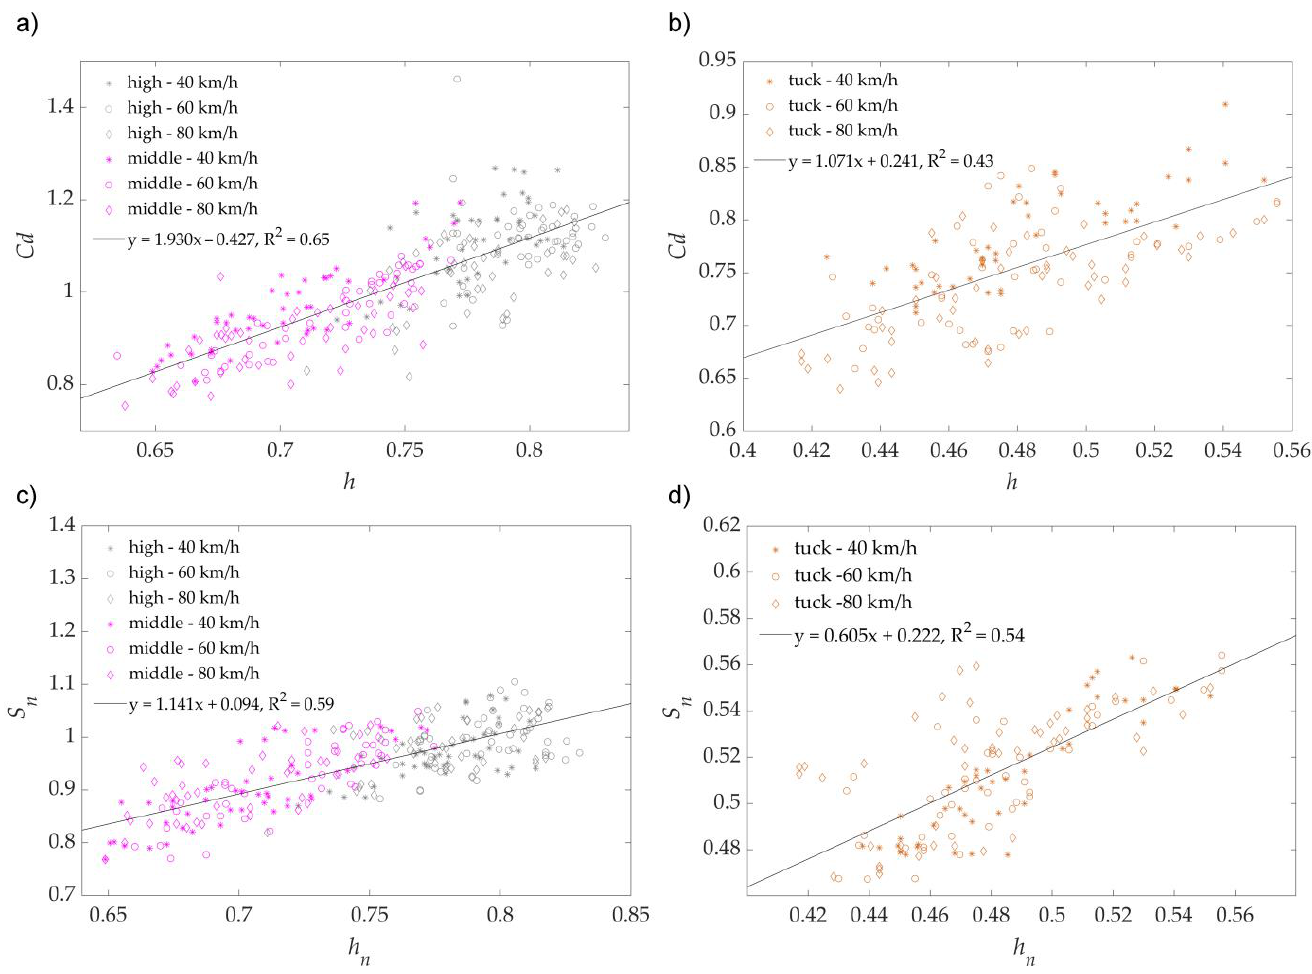
Figure 2. Linear regression model with R 2 values for the product of the coefficient of aerodynamic drag and cross-sectional area (C d ∙S) as a function of normalized shoulder height (h n ) ( a ) in the high (violet) and middle positions (grey)); ( b ) in the downhill (tuck) position (brown).